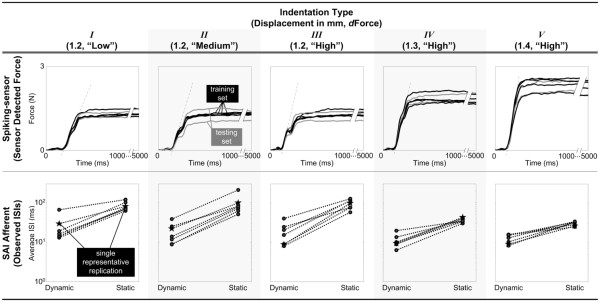
Dependent metrics as inputs into parameter fitting and model validation procedures. Top panel: amongst 30 stimulations across all five types, 20 were selected as training set (black) to fit the model, while the remaining 10 were reserved for the test set (gray) to validate the model. Bottom panel: amongst 35 stimulations spanning all five types, 5 (star pairs) were pseudorandomly selected to represent each of the types.